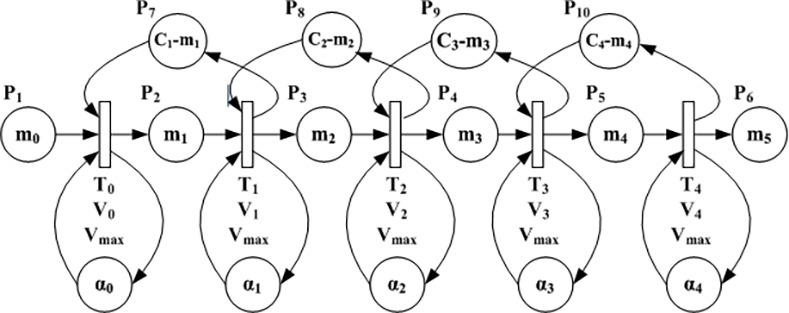
VCPN traffic model.